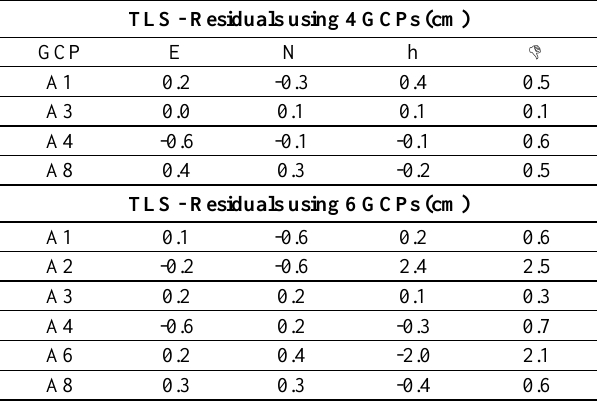
Table 4a. Georeferencing residuals on GCPs measured in fast- static mode for